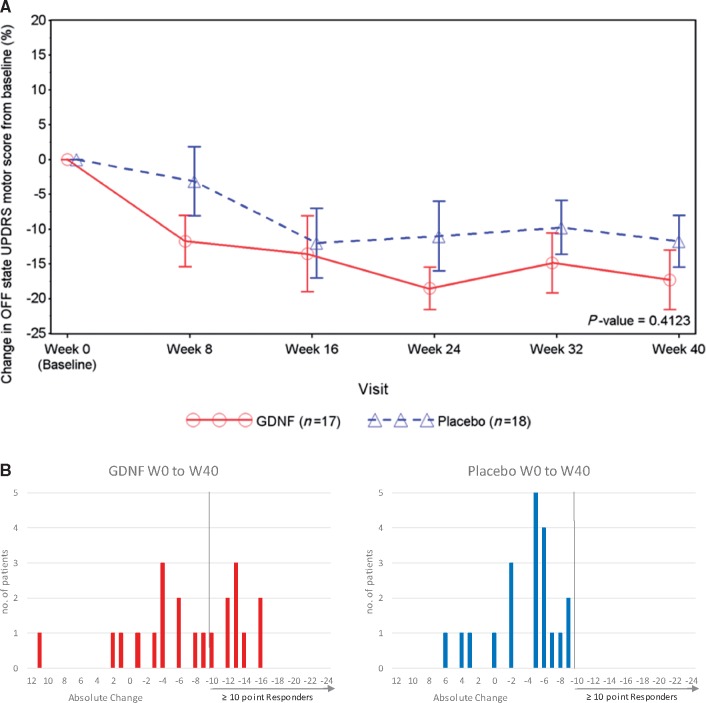

OFF state UPDRS motor score. (A) OFF state UPDRS motor score: percentage change over time. Note that data points represent means, and error bars represent standard errors. One GDNF patient had a conus injury due to a car accident and was included in the motor score without items 22, 27, 28, 29, and 30. The P-value is from a MMRM for the percentage change from baseline to Week 40 between treatment groups. (B) Frequency distribution of change from baseline to Week 40 in OFF state UPDRS motor score (intention-to-treat overall population = primary stage and pilot stage patients, n = 41).